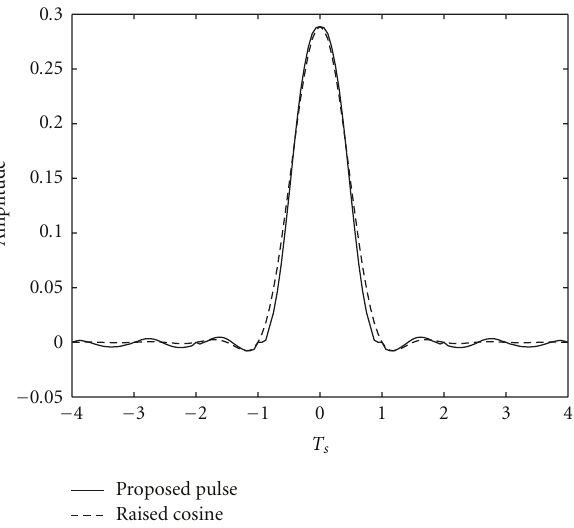
Figure 4: Pulse-shapes in the time domain for symbol rate 12.19